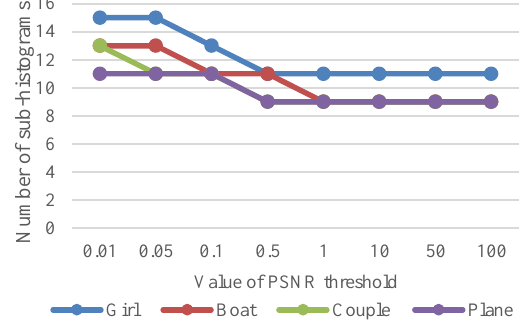
Figure 2. PSNR threshold to number of sub-histograms ratio.